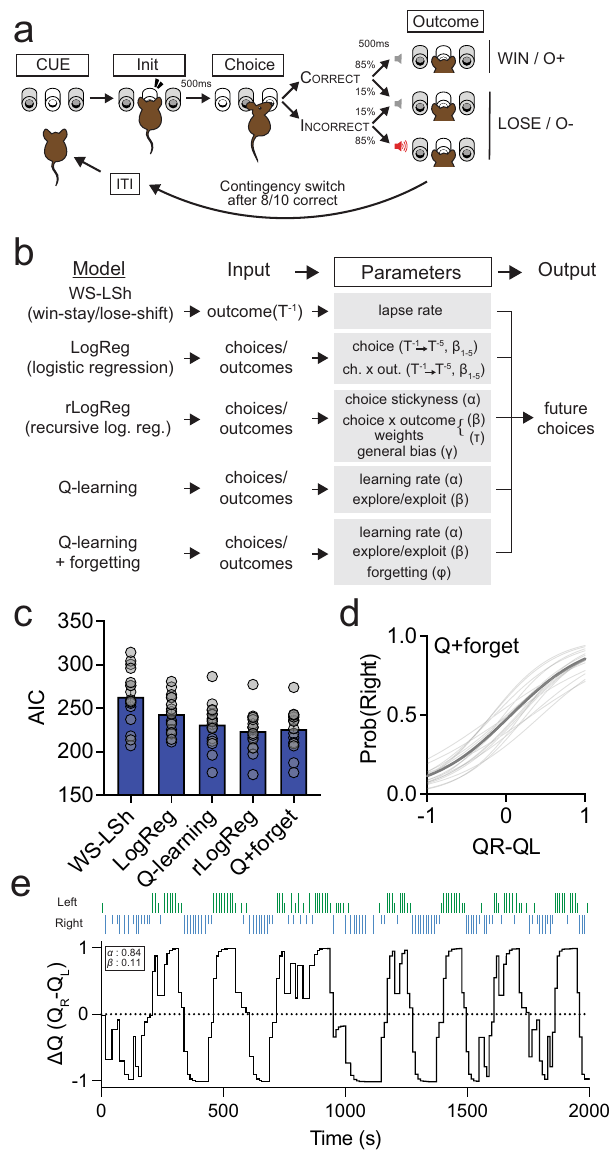
Fig. 3 | Quantifying behavior models of a value-based choice task. a Schematic of trial structure showing mice initiating trials via sustained (500 ms) center port entry,followedbyleft/rightchoicewithin3s.Subsequentrewardisdeliveredfrom center port. b Five behavior models using choice and reward history to predict current animal choice. c AIC comparison (mean ± SEM) from fi ve behavior models of choice behavior (WS-LSh, WinStay-LoseShift; LogReg, Logistic Regression; Q -learning, standard q-learning model; rLogReg, recursive Logistic Regression; Q +forget, q-learning model with forgetting for unchosen choice). d Relationship between the probability of right choice and Δ Q value obtained from Q +forget model. Mean (thick gray line) and individual animal replicates (thin gray line). e Trial-by-trial choices (blue bar, right; green bar, left), outcomes (long bar, posi- tive; short bar, negative) and predicted Δ Q-values derived from Q + forget